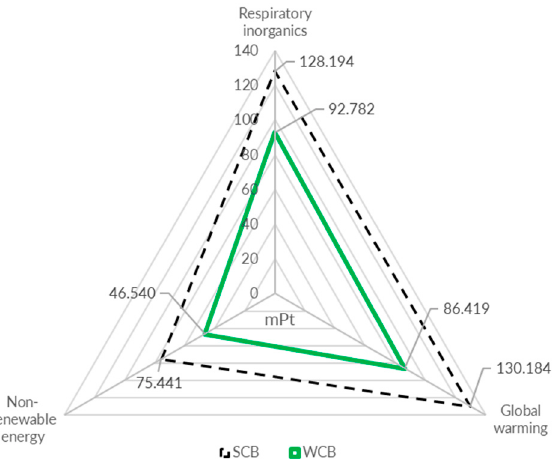
Figure 9. Comparison of three most significant WCB and SCB environmental damage (mPt) per m 2 (SimaPro, IMPACT 2002+, midpoint categories).